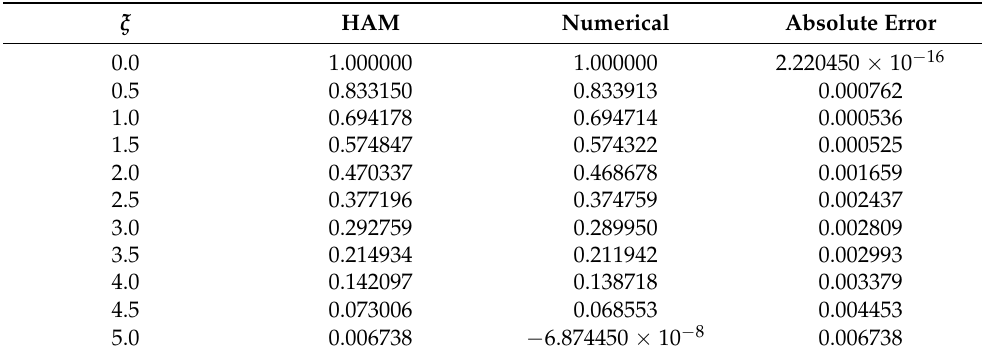
Table 7. Comparison of HAM and numerical methods for concentration function when β =